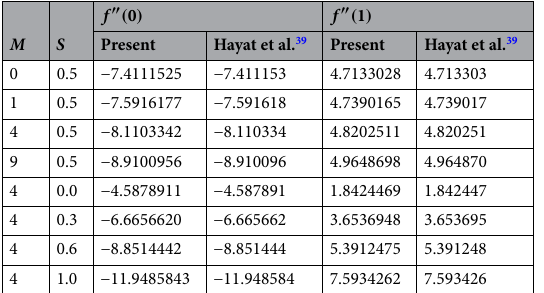
Table 4. Comparative values of f ′′ ( 0 ) -lower plate and f ′′ ( 1 ) -upper plate when Sq = 0 , (cid:31) = 1 , φ 1 , φ 2 = 0 with various S and M .